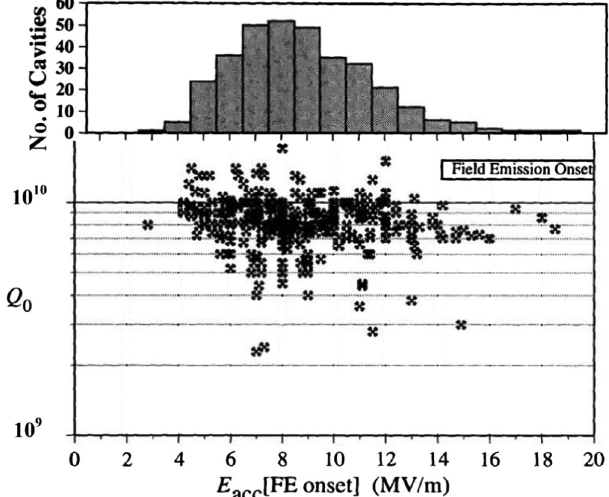
FIG. 5. Cavity performance at onset of detected x rays during pair testing (from